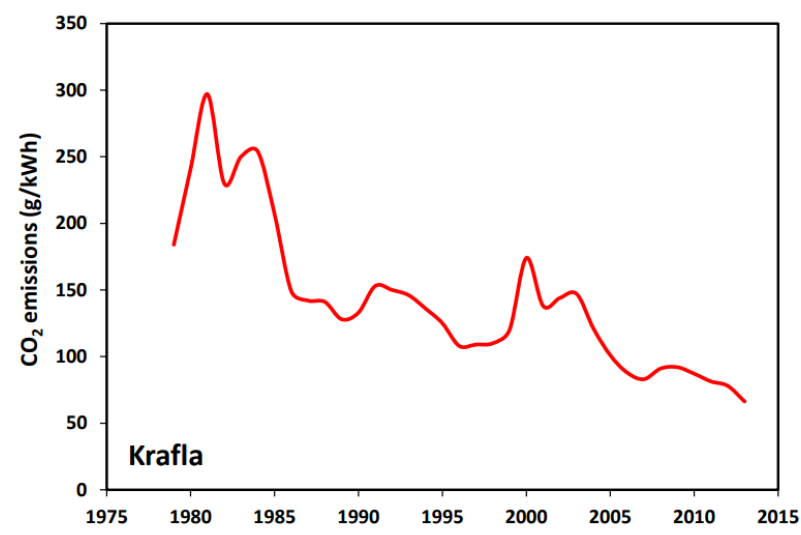
Figure 1. Evolution of CO 2 emissions from Krafla geothermal power plant (after Fridriksson et al. [20]).